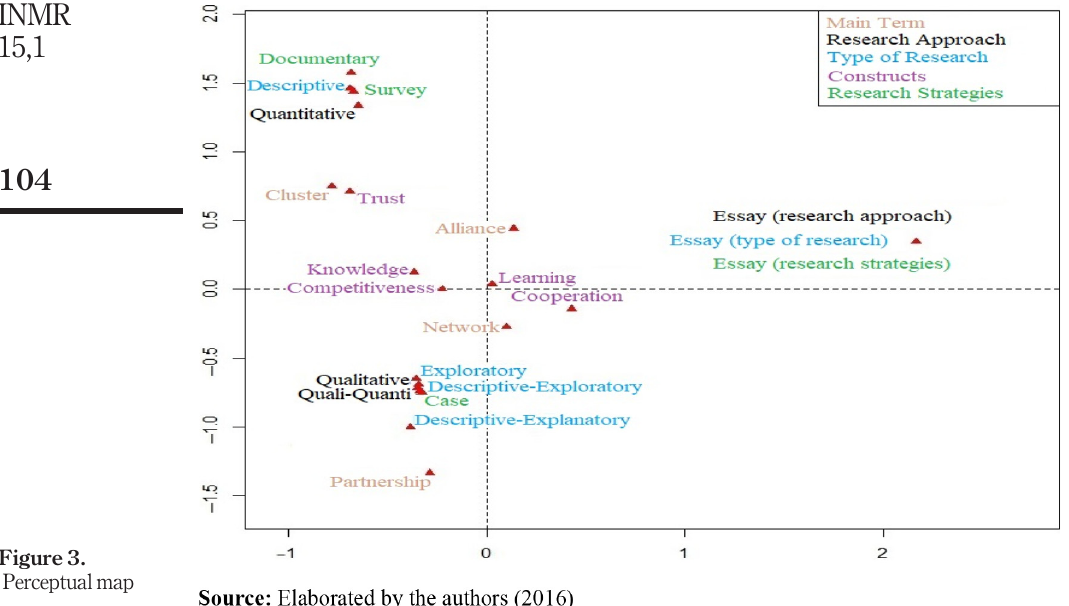
Figure 3. Perceptual